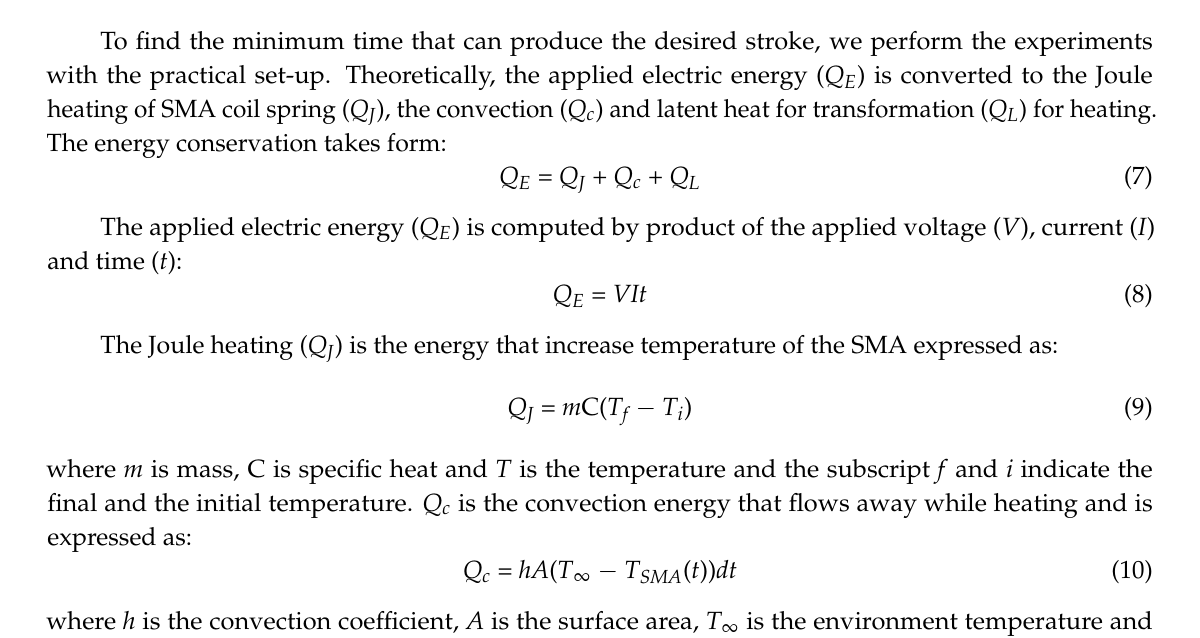
Figure 7. The typical Temperature-Strain relationship of the SMA actuators.